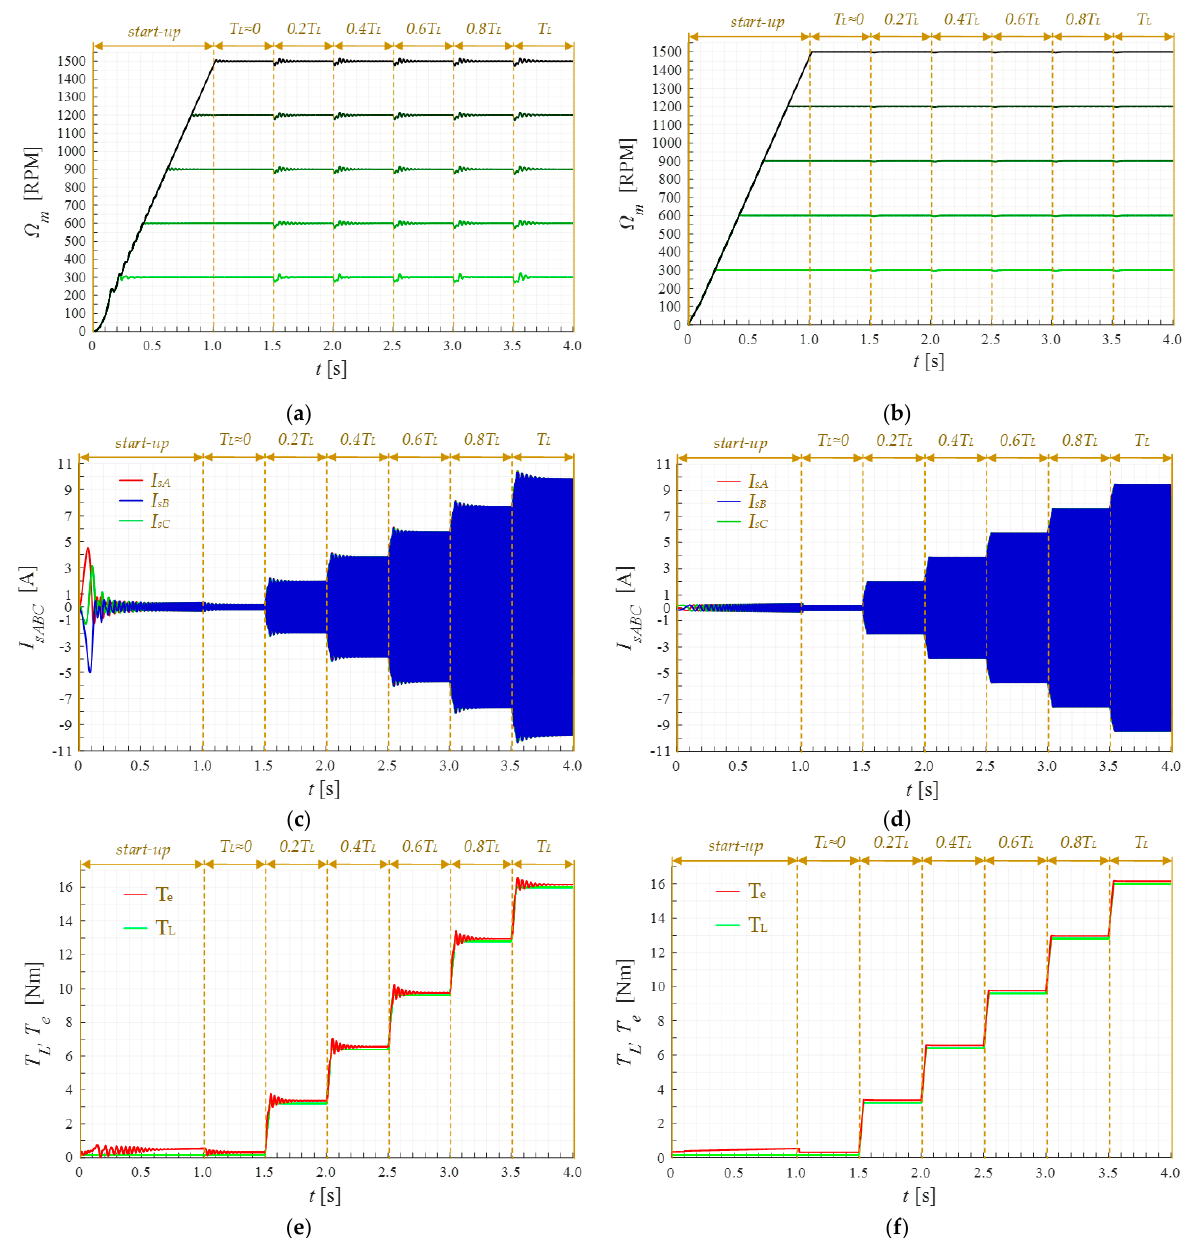
Figure 7. Waveforms of undamaged motor state variables for different values of the load torque, T L = (0–1) T N and for f s = 100 Hz in the scalar control structure (open system with load torque compensation): ( a , c , e ) and in the field-oriented control structure: ( b , d , f ). Transients of the rotor speed ( a , b ), phase current ( c , d ), electromagnetic, and load torques ( e , f ).